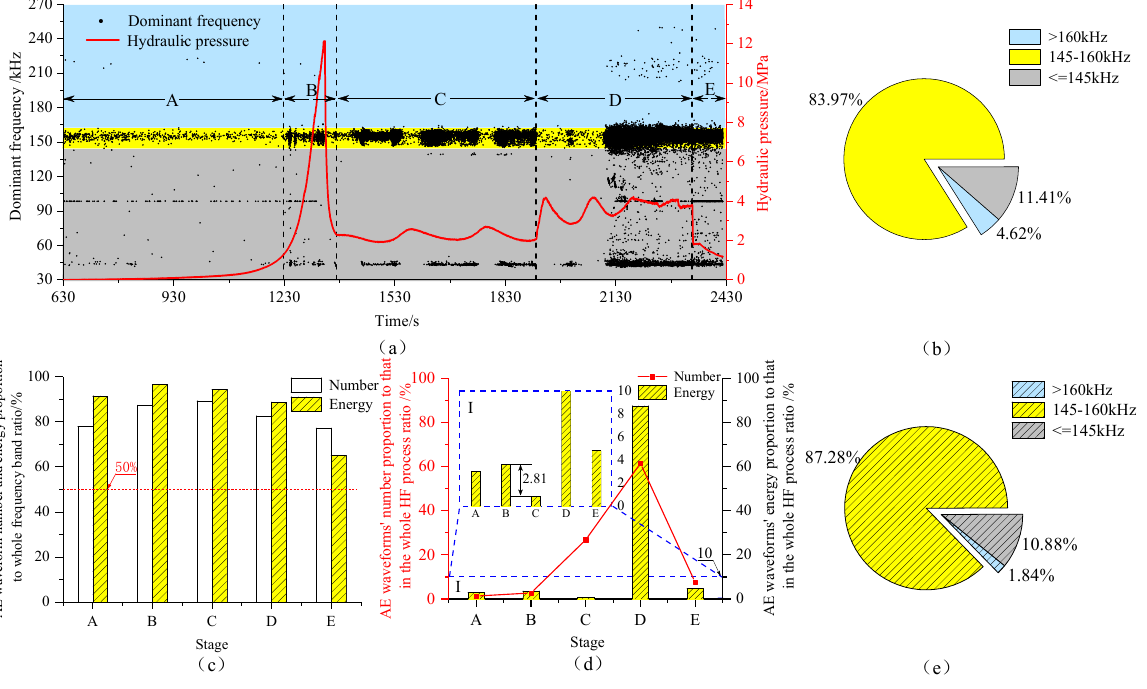
Figure 6. AE waveform dominant frequency distribution during true triaxial HF and characteristics of the AE waveforms’ parameters (number and energy) proportion in the dominant frequency band (( a ) AE waveform dominant frequency distribution in the true triaxial HF, ( b ) AE waveforms’ number proportion of the dominant frequency band to the whole frequency band ratio, ( c ) AE waveforms’ number and energy proportions of the dominant frequency band to the whole frequency band ratio in each stage of HF, ( d ) AE waveforms’ number and energy of the dominant frequency band in each stage to that in the whole HF process ratio, and ( e ) AE waveforms’ energy proportion of dominant frequency band to the whole frequency band ratio). Table 2. The ratio of AE waveforms’ numbers and energy proportions of the dominant frequency band to the whole frequency band in each stage of